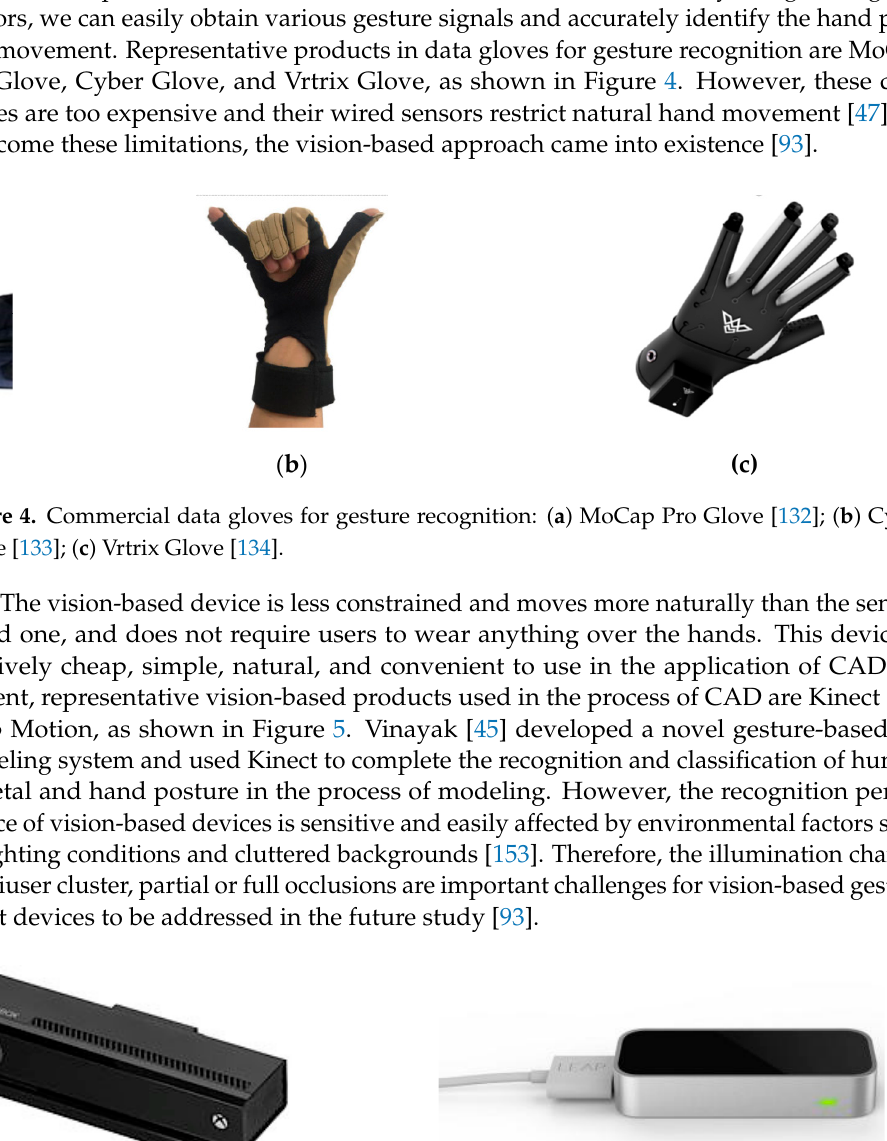
Figure 3. Commercial tabletop eye-trackers: ( a ) Gazepoint GP3 [129]; ( b ) Tobii Pro Spectrum 150 [130]; ( c ) EyeLink 1000 Plus [131].